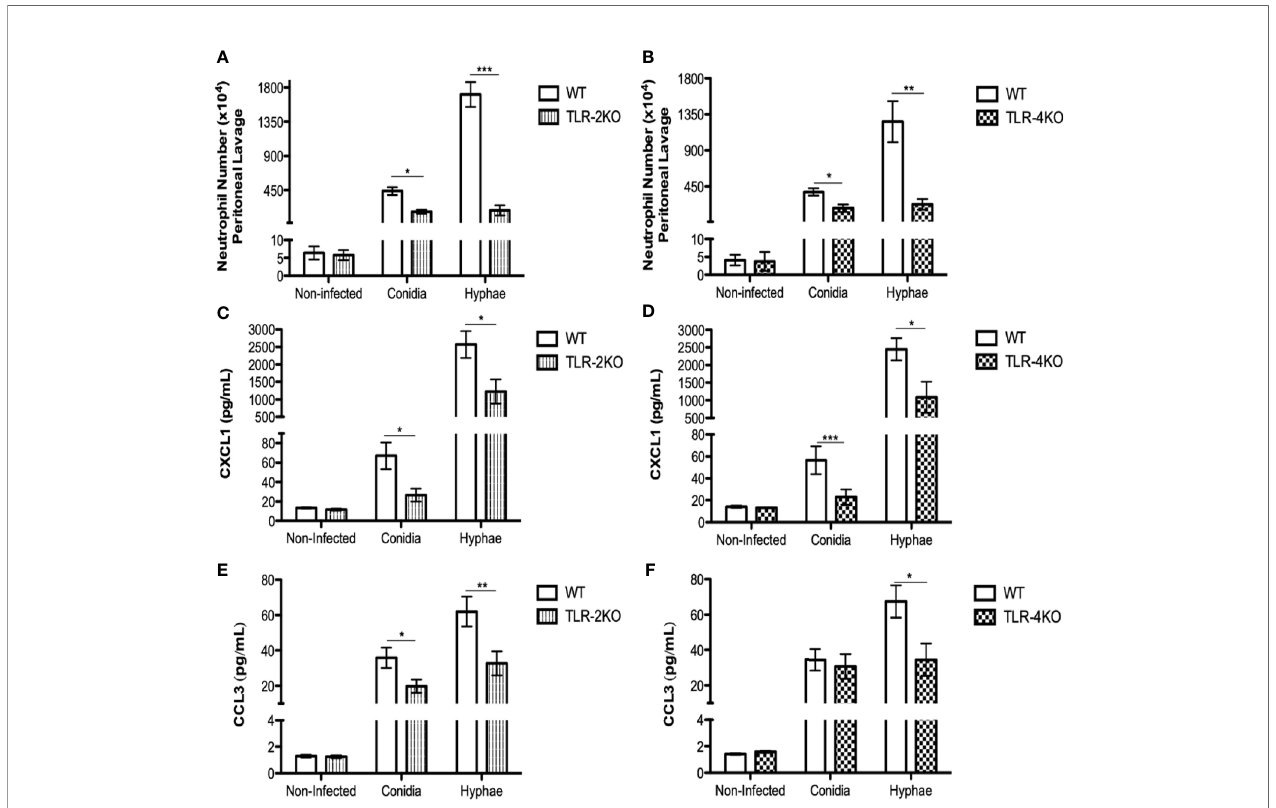
FIGURE 5 | Neutrophil attraction to the conidia- and hyphae-infected site is dependent on TLR-2 and TLR-4 and chemokines CXCL1 and CCL3. WT, TLR-2KO, and TLR-4KO animals were i.p. infected with F. pedrosoi (conidia or hyphae) or PBS as noninfected control. After 3 h of infection, animals were euthanized, and the i.p. lavage were collected with PBS 5% FBS 2 mM EDTA. The lavage was centrifuged, and supernatant was collected to measure chemokines by ELISA (C – F) . Cells were harvested and counted in a Neubauer chamber for staining with anti-CD45, anti-ly6G, and anti-CD11b to detect neutrophil migration by the fl ow cytometry technique (A, B) . Data are expressed as mean ± SEM; n =9 – 13, Student t. * p <0.05; ** p <0.01; *** p